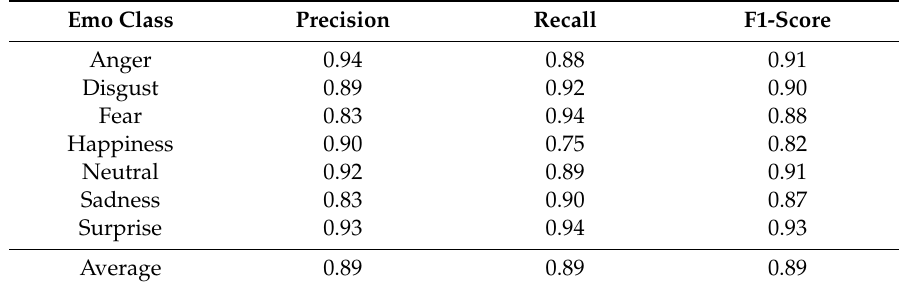
Table 2. Confusion matrix based on TESS and RAVDESS dataset for pretraining.